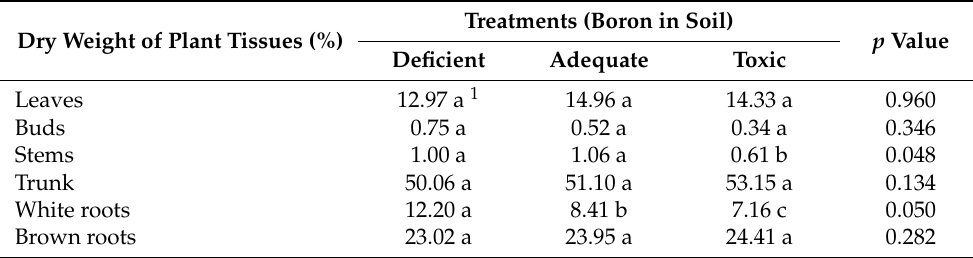
Table 2. Effect of three concentrations of soil boron availability, deficient, adequate, and toxic (0.04, 1.10, 3.75 mg kg − 1 ), respectively, on biomass partition in sweet cherry